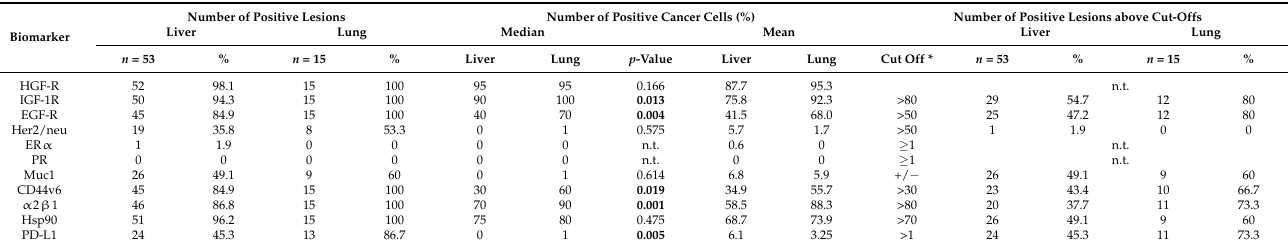
Table 3. Positivity and Distribution of Biomarkers in Liver and Lung Metastases.